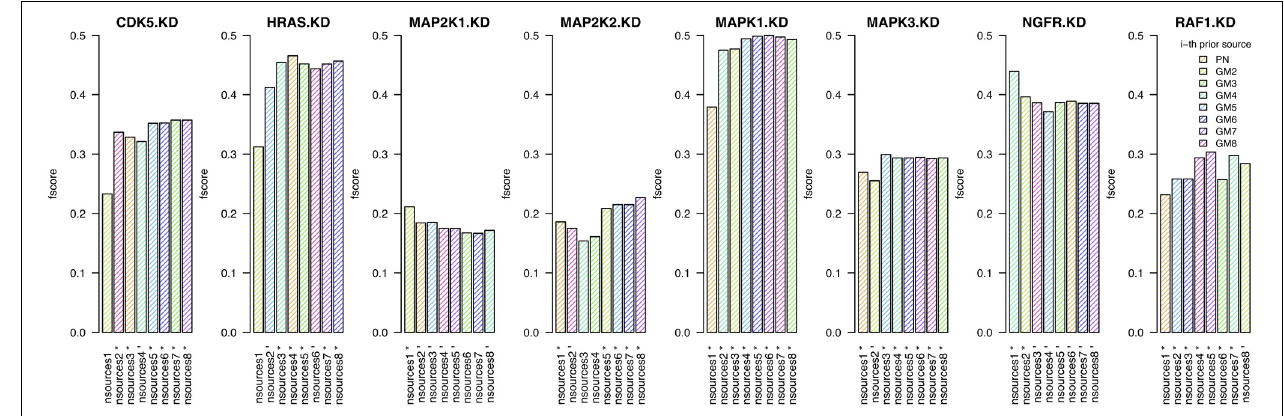
FIGURE 4 | Results when inferring networks with predictionet using expO data and prior knowledge ( w = 0 . 5). The height of each bar corresponds to the obtained F -score, colored by which